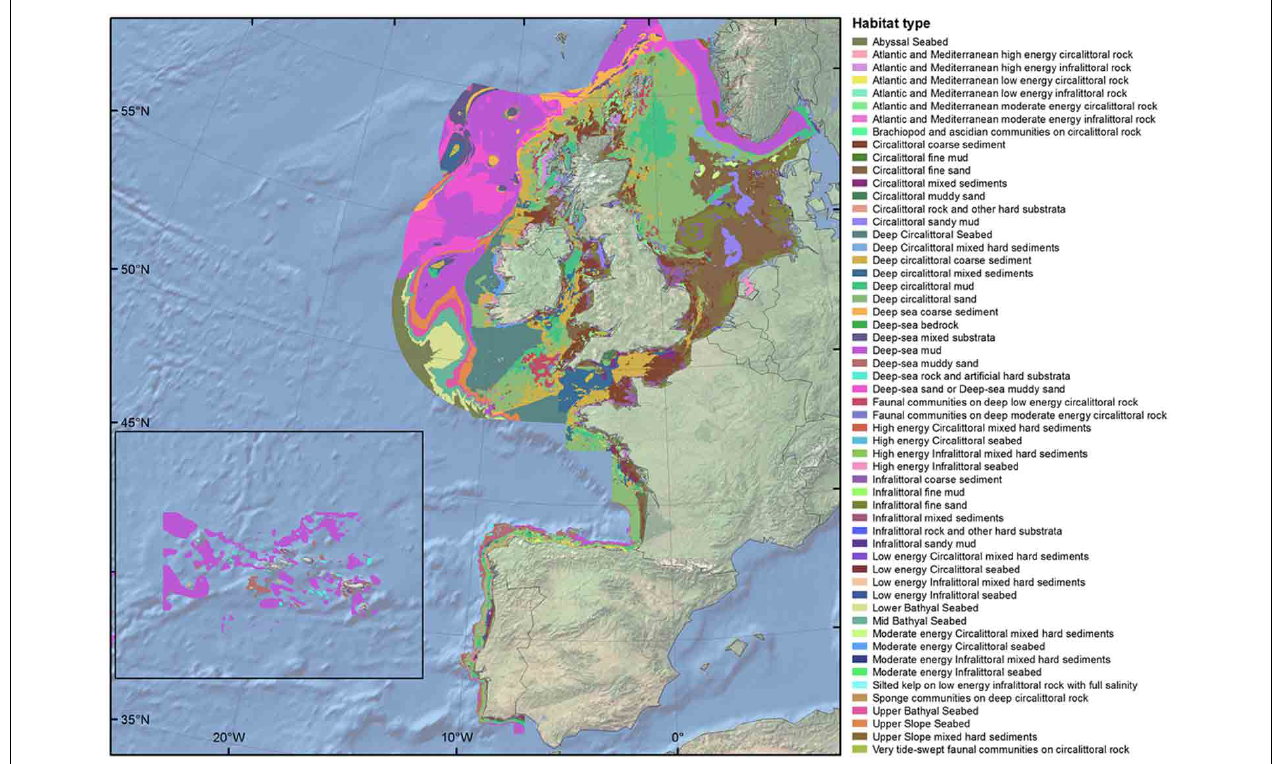
FIGURE 3 | Benthic habitat map distribution within the European North Atlantic Ocean. Habitats are listed in alphabetical order.